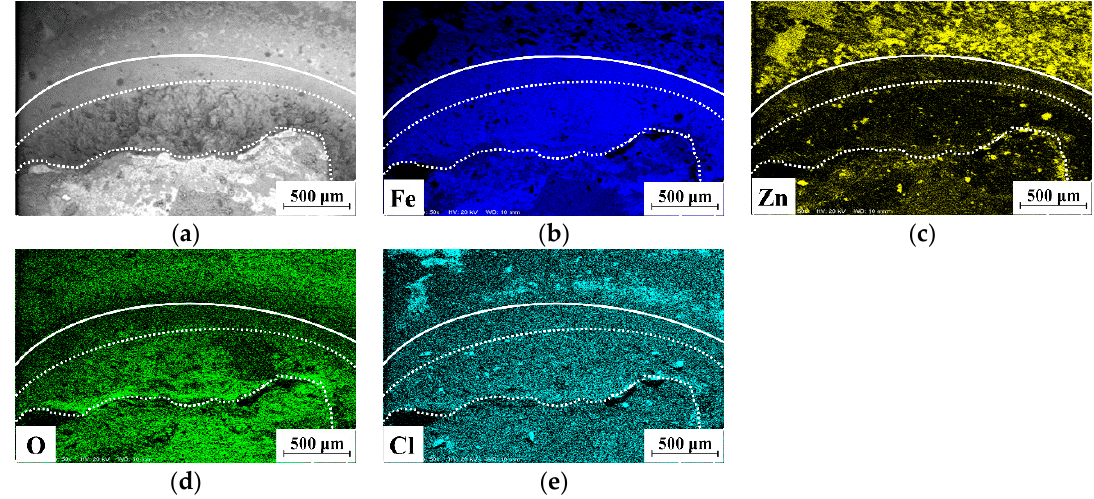
Figure 9. ( a ) SEM micrograph (BSE mode) on weld spot surface and surrounding HAZ of sample no. 1 after the salt spray exposure test. Chemical distribution of elements ( b ) Fe, ( c ) Zn, ( d ) O, and ( e ) Cl, as obtained from energy EDS analysis. White dotted lines point out the border of the fractured spot weld on the sheet (top line) and on the pull out head (bottom line). The continuous line defines the border of the sheet surface without the zinc layer.